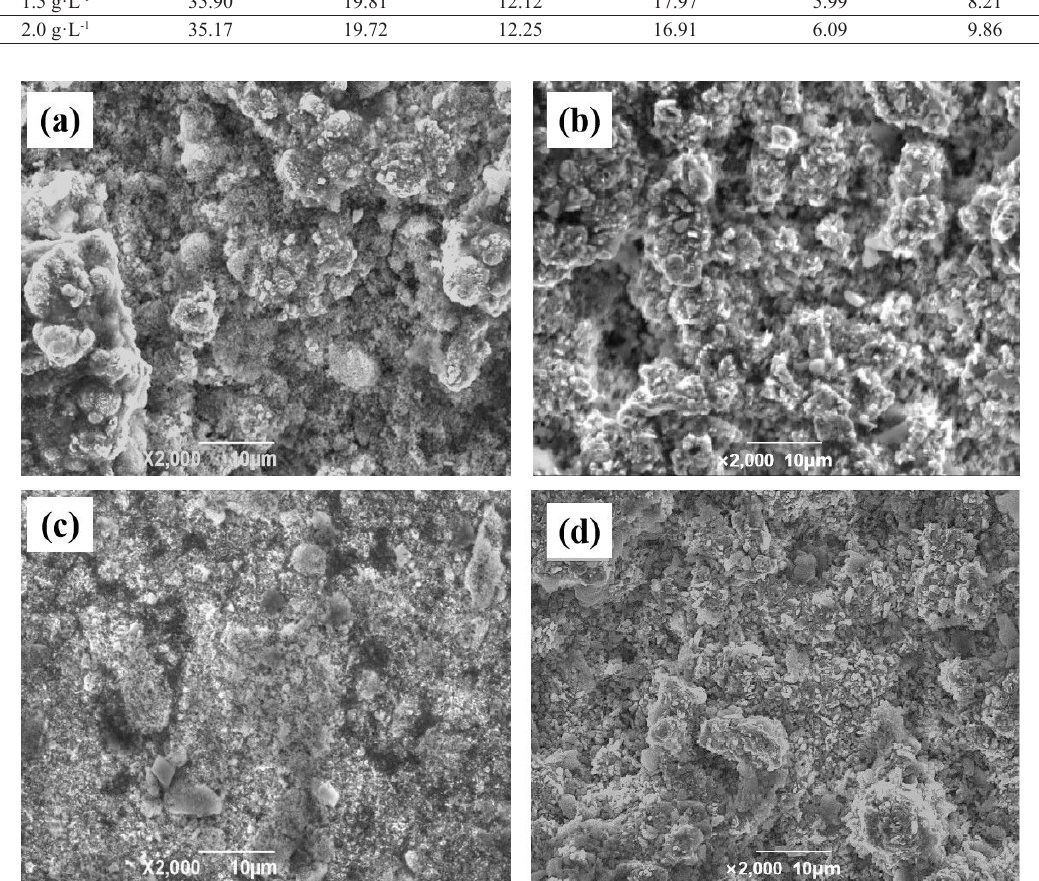
addition: (a) 0.5 g·L -1 ; (b) 1.0 g·L -1 ; (c) 1.5 g·L -1 ; (d) 2.0 g·L -1 . 2